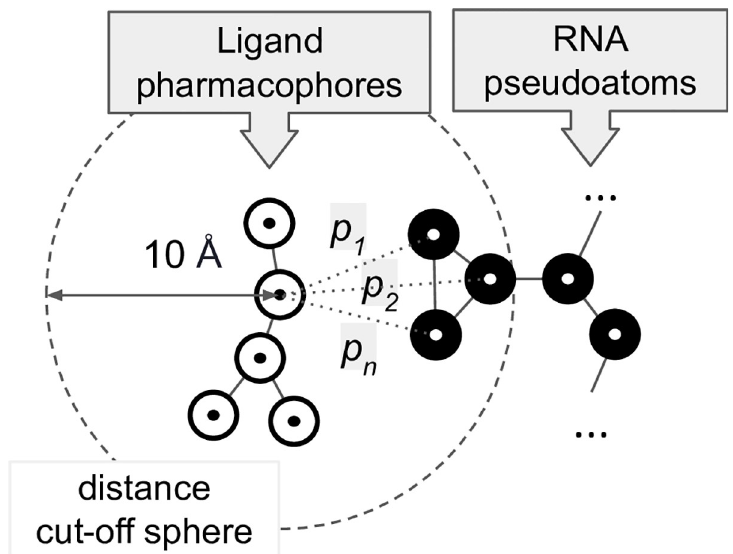
Fig 11. AnnapuRNA scoring function calculates the probabilities p 1 ... p n of interactions between ligand pharmacophores (white circles) with RNA pseudoatoms (black circles) within the distance of 10 Å . The total score is calculated as a negative sum of all probability values p calculated for the given